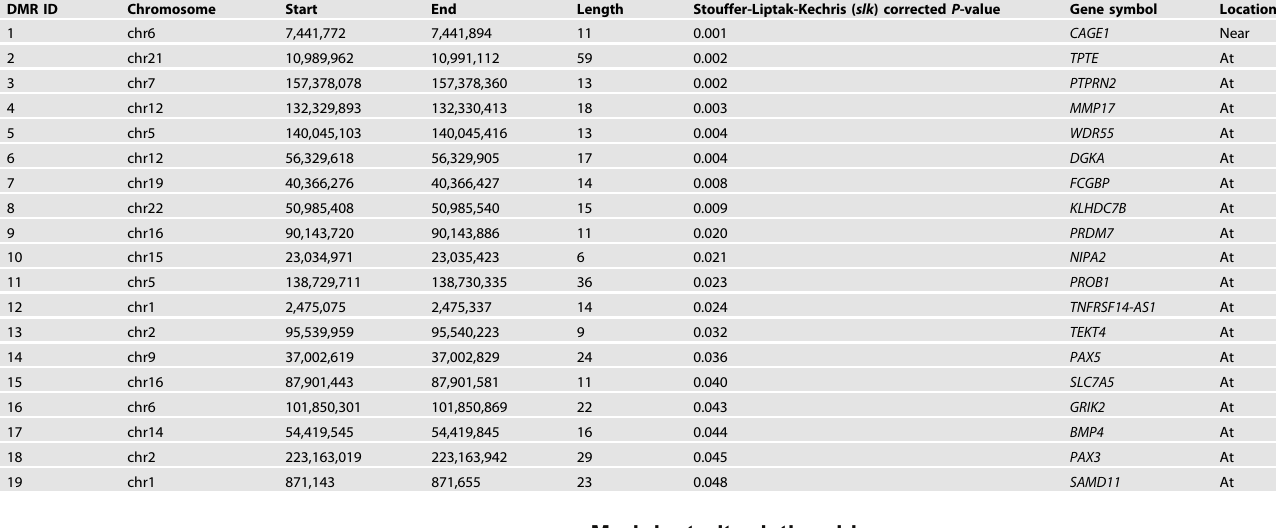
Table 4. The results of annotation to signi fi cant differentially methylated regions (DMRs) ( slk corrected P -value < 0.05). DMR ID